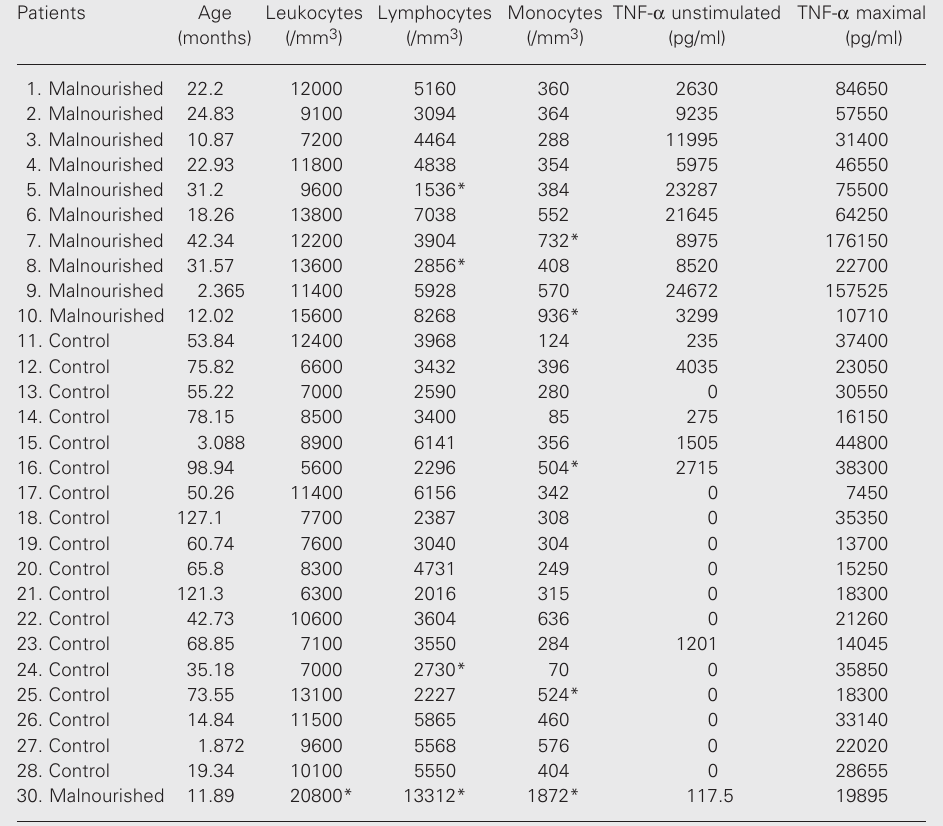
Table 4. Tumor necrosis factor alpha (TNF- α ) production in 24-h whole blood cultures and total and mono- nuclear leukocyte counts for the study